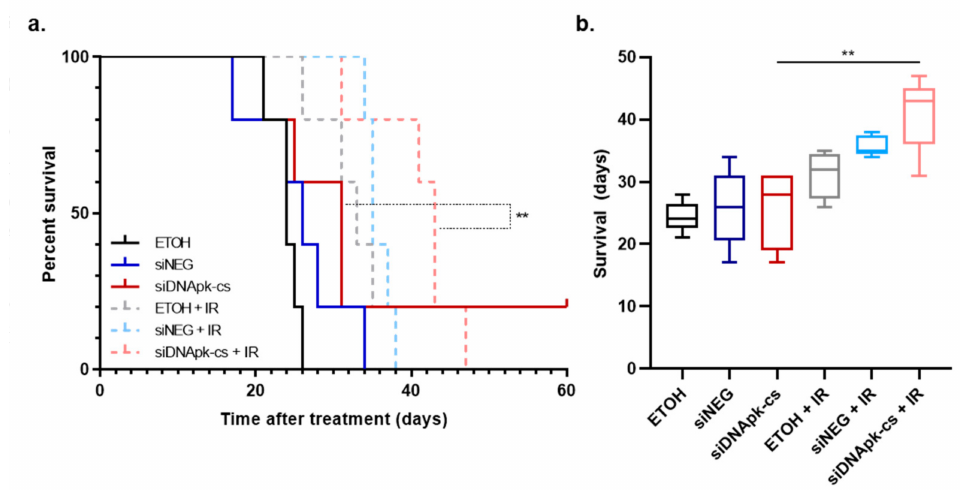
Figure 6. E ff ect of ECO nanoparticle (NP) delivery of siDNApk-cs on the radioresponse of U251 orthotopic xenografts. ( a ) Kaplan–Meier survival curves showing the e ff ect of siDNApk-cs delivery by RGD-PEG labeled ECO NPs. Significance calculated using log-rank analysis (** p < 0.01). One mouse in the siDNApk-cs alone and ethanol (ETOH) + IR groups displayed complete tumor regression. Mice were monitored until the onset of morbidity. ( b ) Median survival of experimental groups. Significance calculated using ANOVA with Tukey post-analysis (** p <